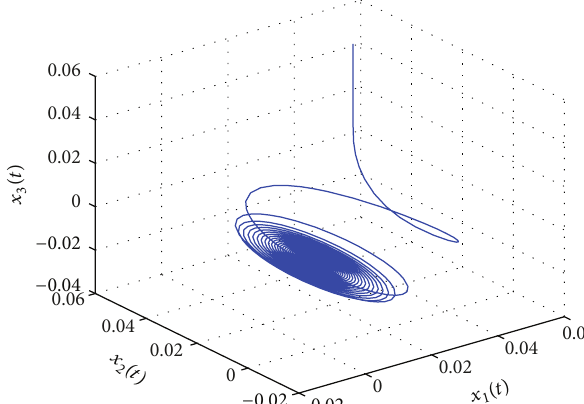
Figure 2: The phase plot of 𝑥 1 , 𝑥 2 , and 𝑥 3 when 𝜏 1 = 1.3 < 1.4022 = 𝜏 10 .